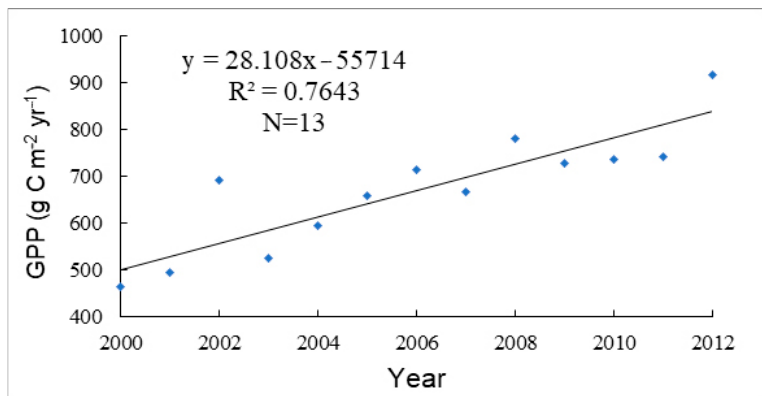
Figure 7. Trend in mean annual GPP in the typical area during 2000–2012.